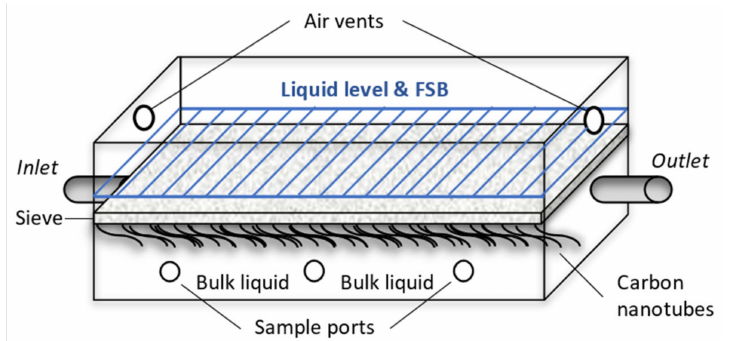
Figure 1. Simplified diagram of a hybrid linear flow channel